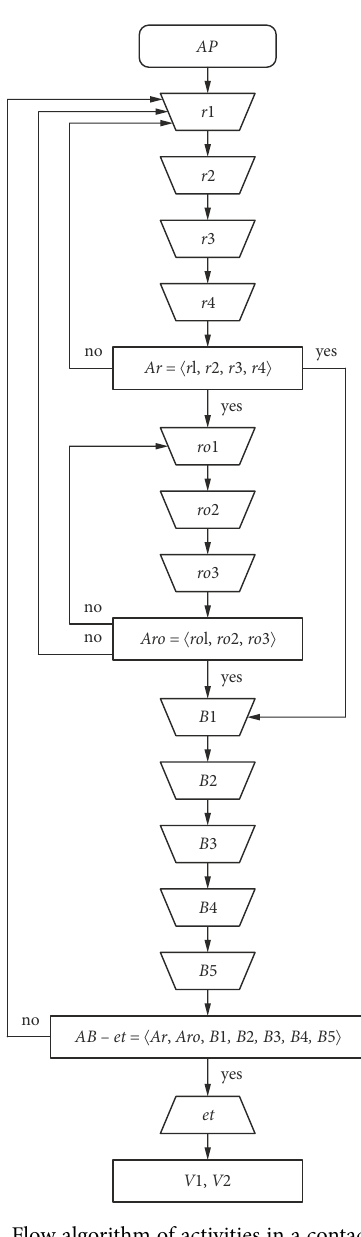
Figure 5. Flow algorithm of activities in a contactless ICT transaction model of urban transport